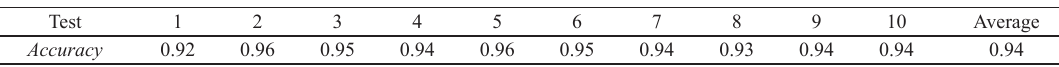
Figure 7. Response of different Gabor filters: (a) original image; (b) Gabor 1 with theta equal to 0; (c) Gabor 1 with theta equal to π/2; (d) Gabor 2 with theta equal to 0; (e) Gabor 3 with theta equal to 0; and (f) Gabor 4 with theta equal to 0. Table 4. Accuracy of the tests in the stratified 10-fold